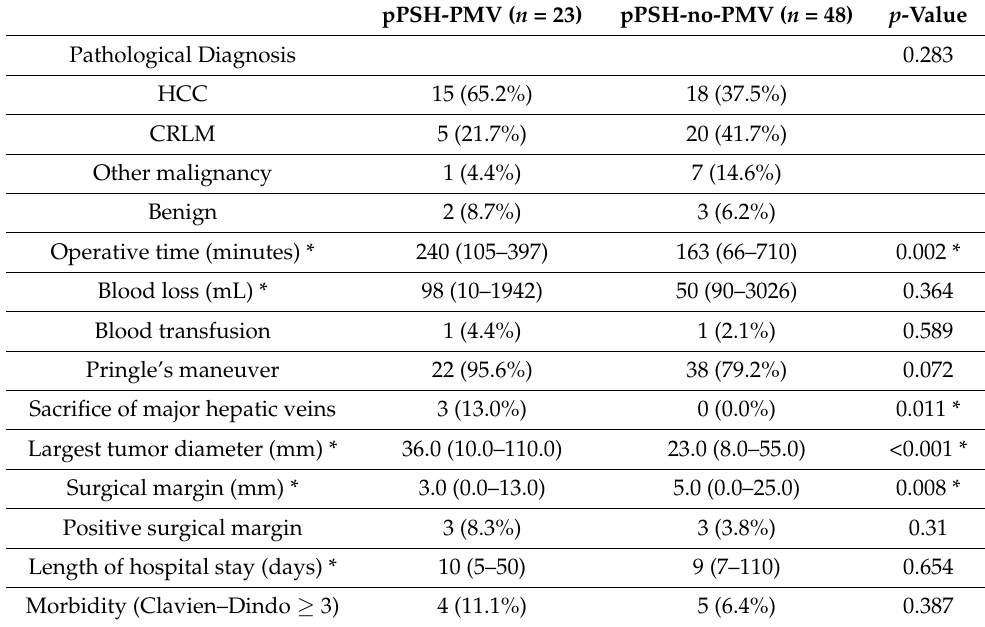
Table 8. Surgical outcomes of pPSH-PMV and pPSH-no-PMV